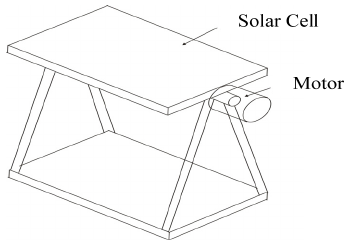
Figure 10. Sun track system diagram.